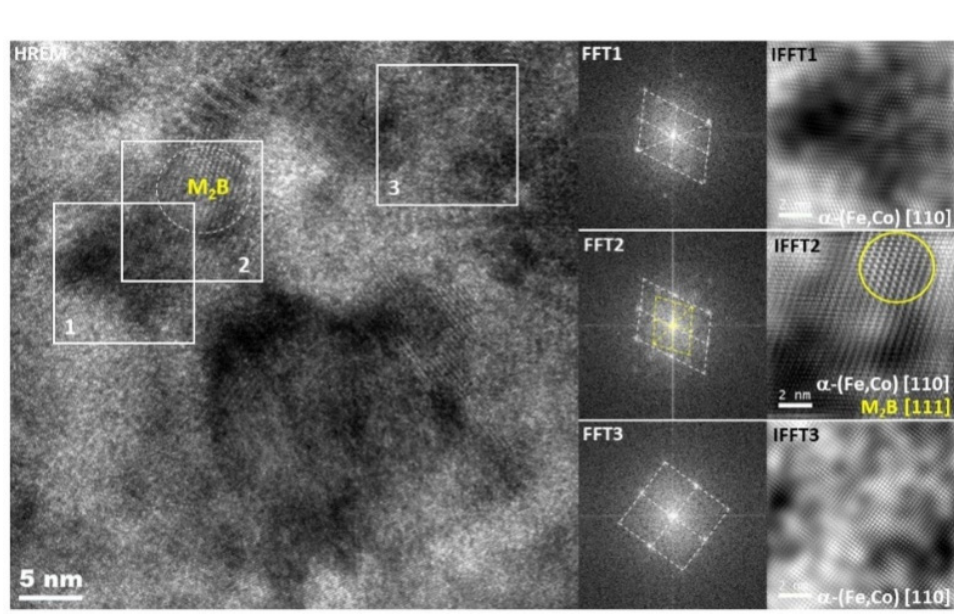
Figure 8. The example of BF and DF images of the Fe 64.5 Co 20 Nb 5 B 8.5 P 2 ribbon taken at 500 and 600 °C.